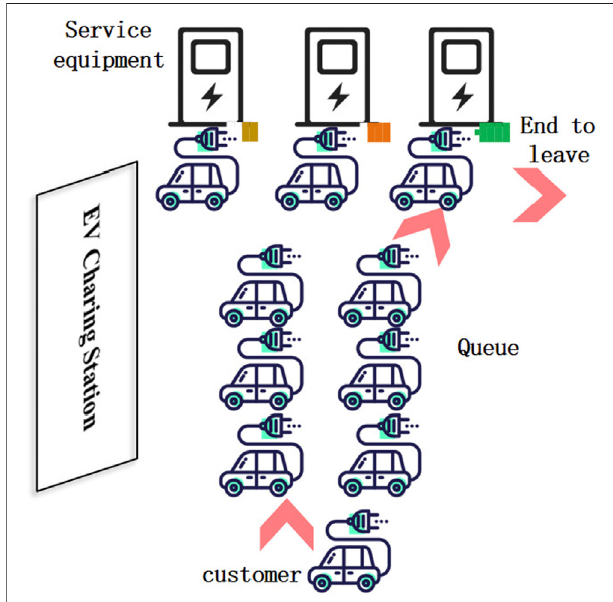
FIGURE 4 | PHEV queuing